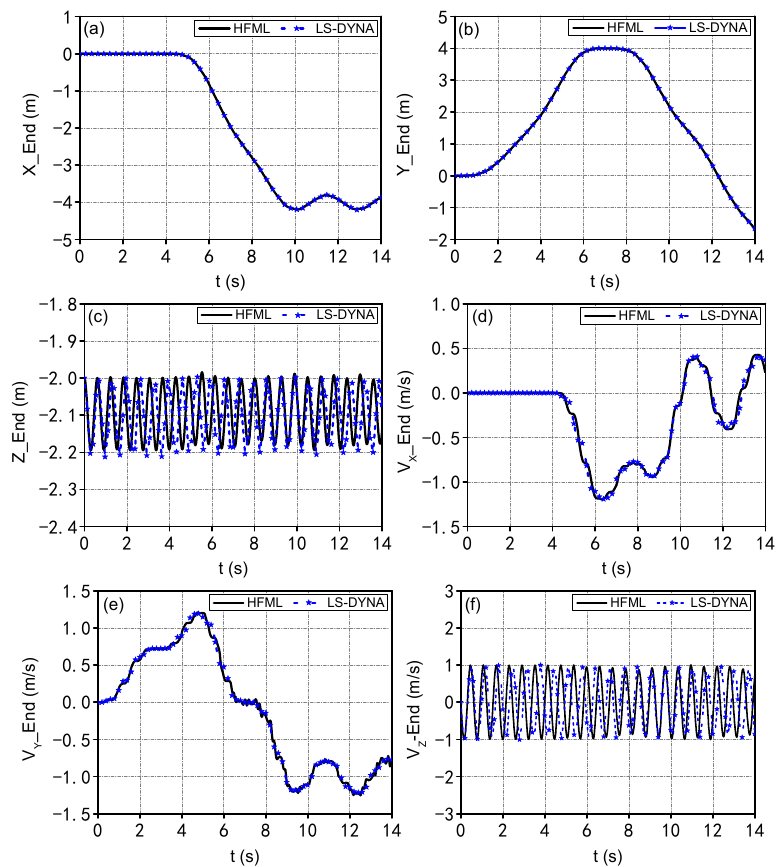
Figure 8. Position and velocity responses of the free end of towed cable: ( a ) X -axial component of the free end position, ( b ) Y -axial component of the free end position, ( c ) Z -axial component of the free end position, ( d ) X -axial component of the free end velocity, ( e ) Y -axial component of the free end velocity, ( f ) Z -axial component of the free end velocity. For the 180 0 U-turn towing process, Figure 9 illustrates the configurations of the cable calculated by HFML and LS-DYNA. The maximum dynamic strain is 9.75%. The simulat- ing configurations by HFML and LS-DYNA fit perfectly with each other. The comparisons show that HFML using the logarithm strain representation can predict accurately the dy- namic large strain configurations of the flexible cable.